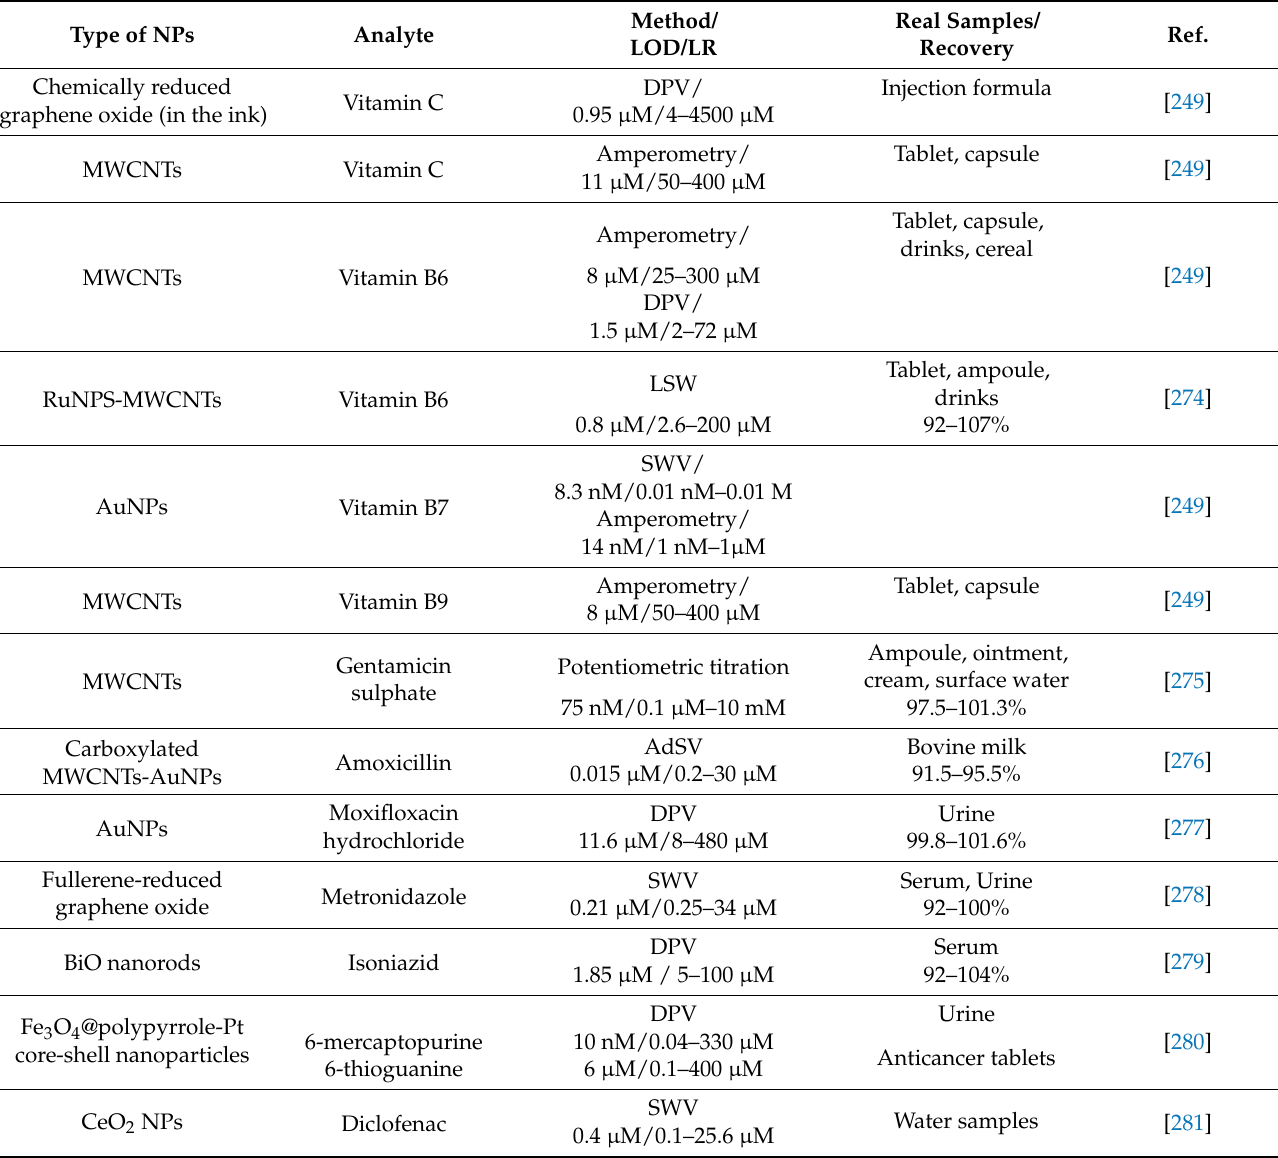
Table 2. Screen-printed electrodes modified with various nanomaterials for pharmaceutical applications (some examples). Type of